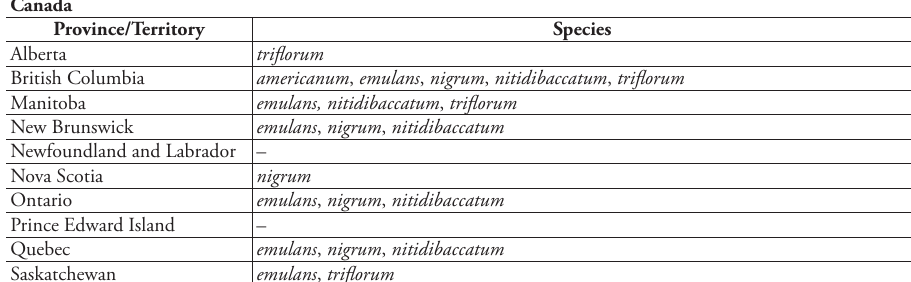
Table 5. Distribution of morelloid species by political division in continental North America (Canada and the United States [excluding Hawaii*]) based on specimens seen and verified for this treatment. Many of these species are adventive and are to be expected to occur widely in disturbed habitats (e.g., S. nigrum , S. nitidibaccatum , S. sarrachoides ); we have not listed records for which we have been unable to examine vouchers for verification. Species known only in cultivation are in parentheses (). Adventives are distinguished in Table 4 but not here. Solanum pilcomayense is known from two old collections ( Reverchon 3918 from Sabine Pass, Texas, coll. 1905; Parker s.n. from Camden, New Jersey, coll. 1874) and is listed here, but not treated (see pg. 4,